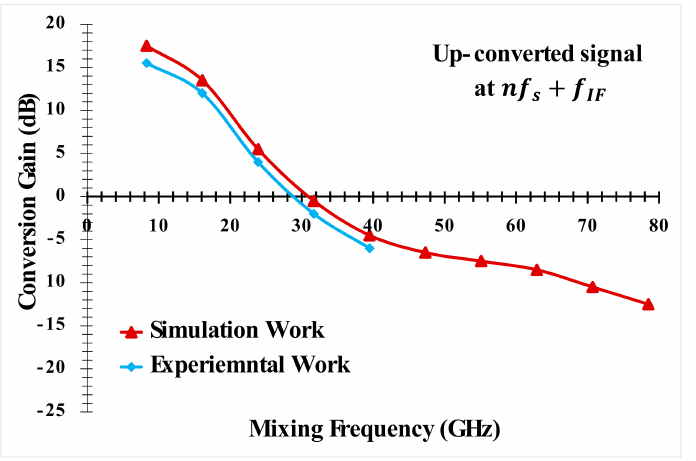
Figure 10. Up-conversiongainatseveralmixingfrequenciesfrom f s + f IF =8.3GHzto10 f s + f IF = 78.5